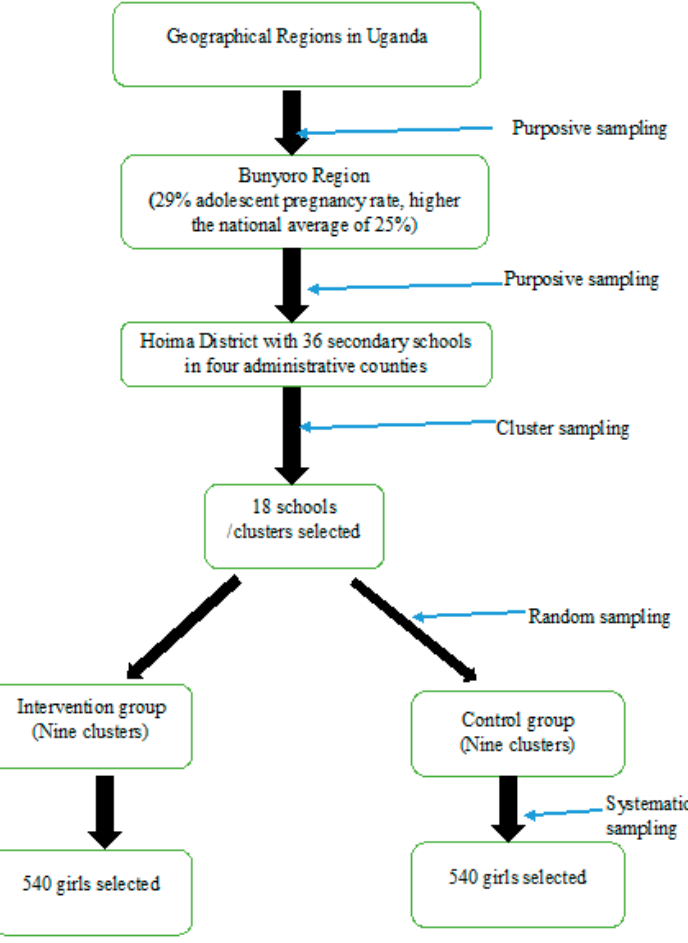
Figure 1. Flow chart on the Sampling framework. Source: Primary data 2018.